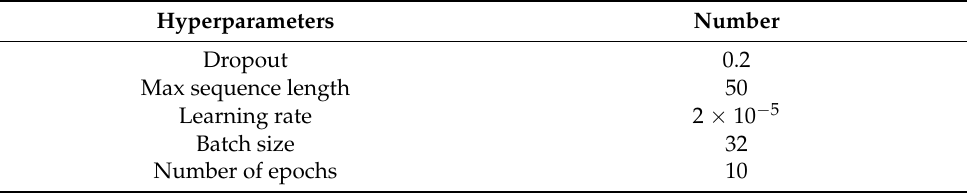
Table 3. EBA model hyperparameters table.